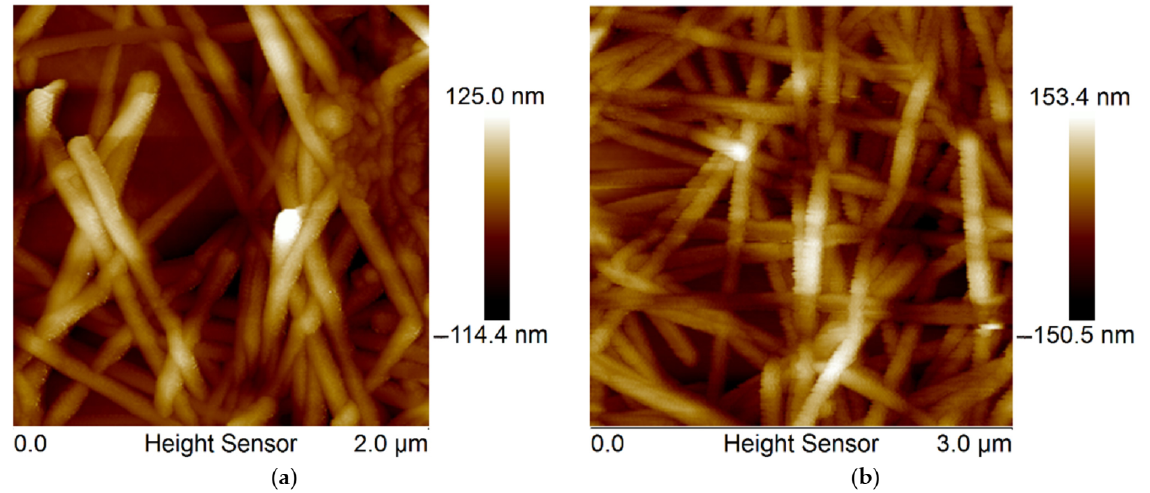
Figure 6. AFM images of AgNW films: ( a ) before sputtering with MoS 2 ; ( b ) after sputtering with MoS 2